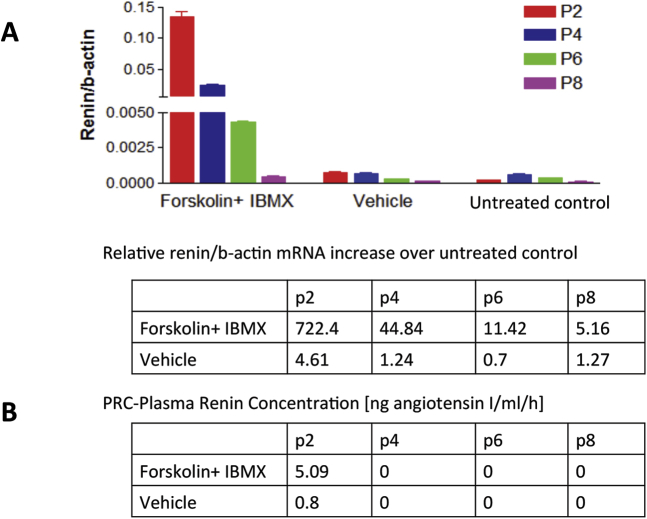
Diminished renin induction response in the primary cultures of human kidney pericytes over time. Renal pericytes isolated from the fetal human kidney upregulate renin expression when treated with cyclic adenosine monophosphate inducers. Cells underwent renin induction at different passages (p2, p4, p6, and p8). (A) Quantitative polymerase chain reaction (PCR) demonstrated a dramatic reduction in the ability to re-induce renin over increasing number of culture passages. (B) Renin activity assay showed an enzymatic activity present at passage 2 (p2) only. Data are shown as means ± SEM (n = 1). Error bars are calculated from technical replicates. IBMX, isobutyl-1-methylxanthine.